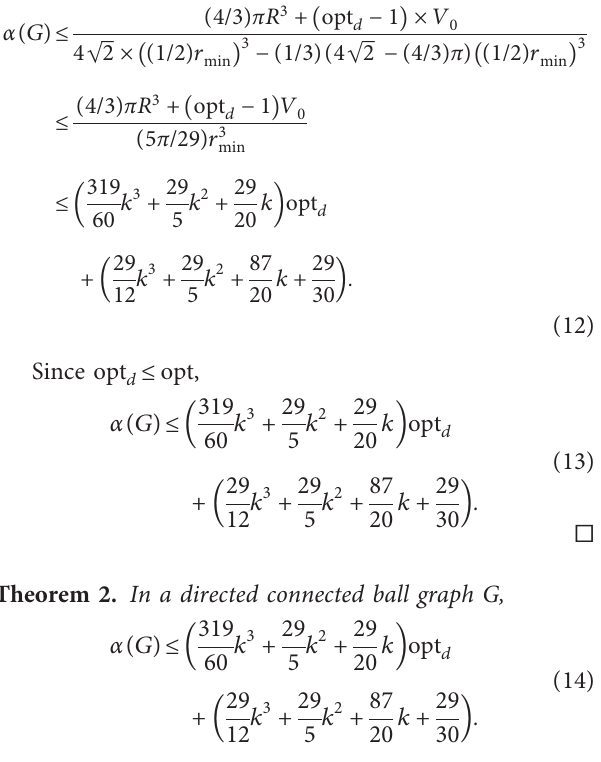
Figure 5: Illustration of two balls with centers e ,e ) ≤ r d ( e i j max